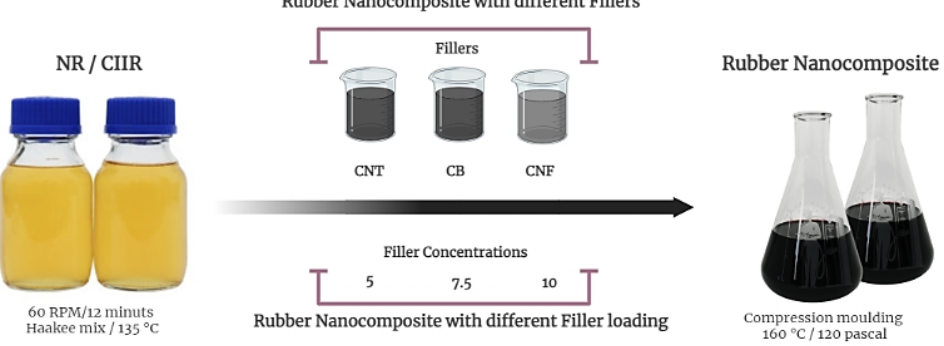
Figure 1. Scheme for the synthesis of NR/CIIR-based polymer nanocomposites.